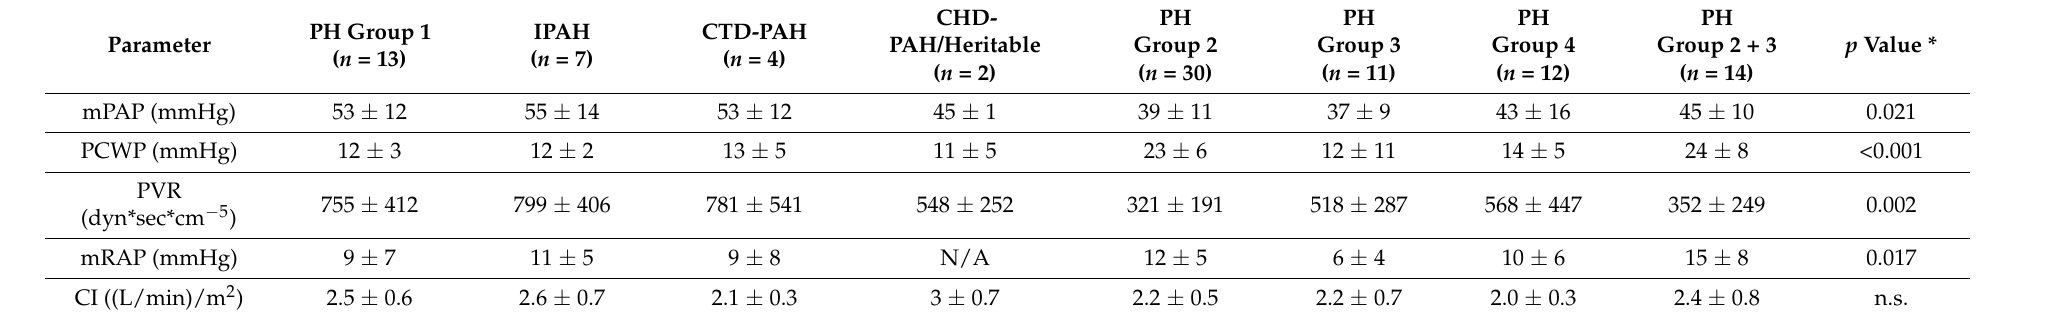
Table 3. Hemodynamic parameters of the different PH groups as well as the subgroups of PH group